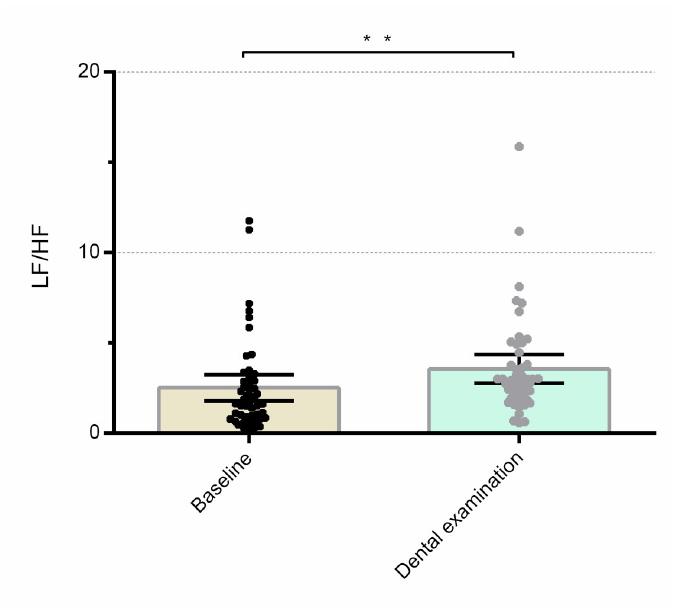
Fig 5. Mean heart rate variability as LF/HF during the baseline and the dental examination. Error bars indicate a 95% confidence interval; �� p < 0.05.